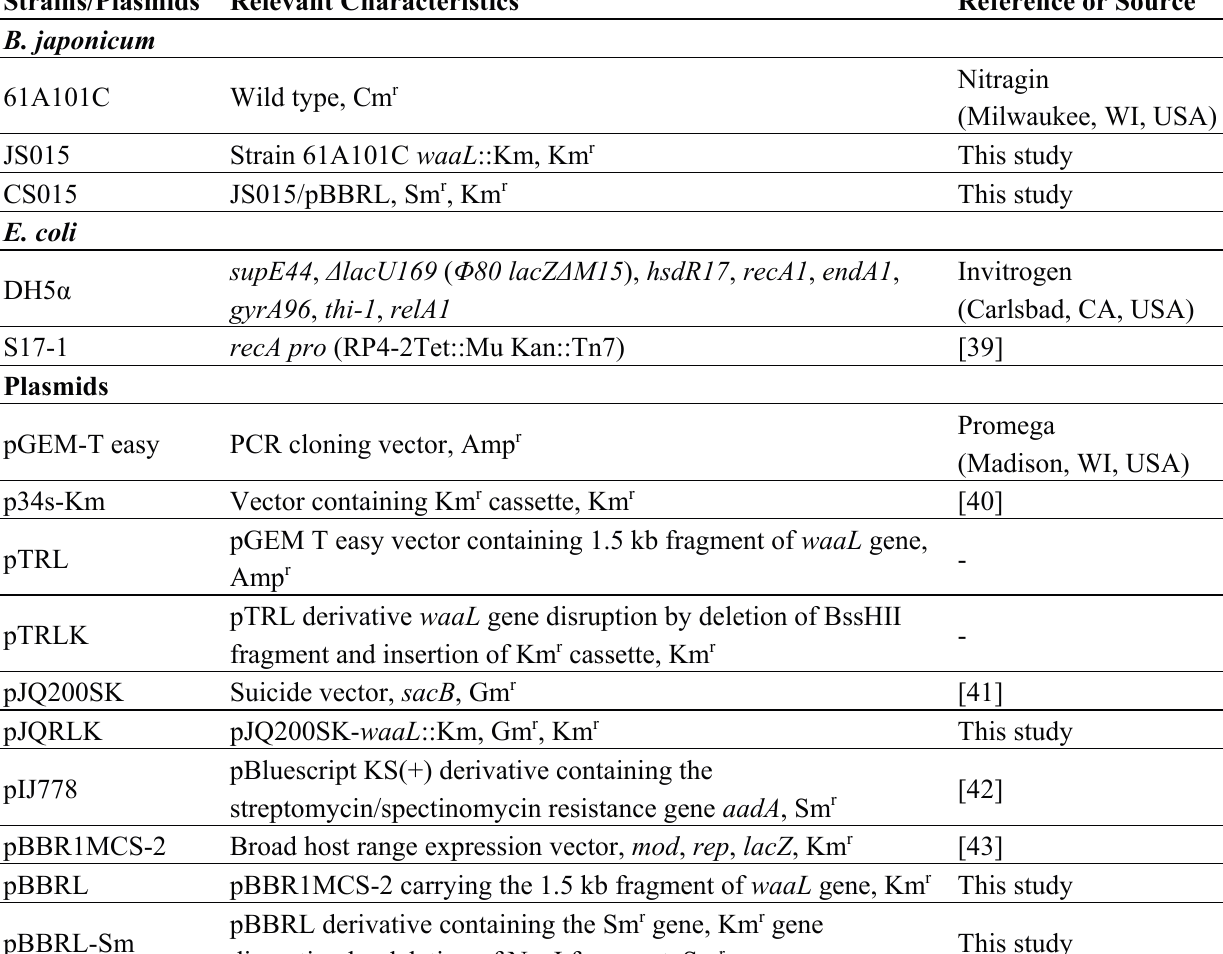
Table 2. Bacterial strains and